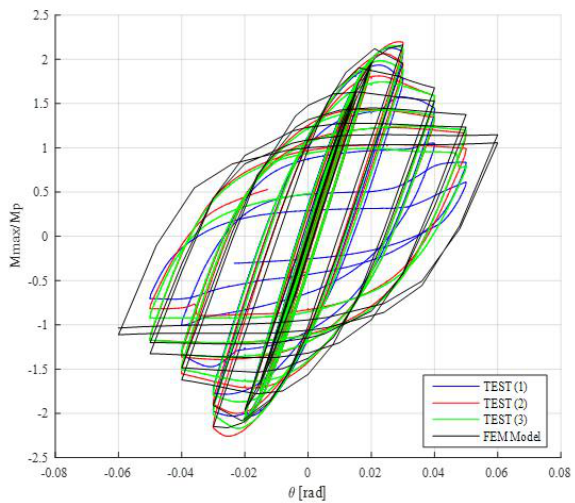
Figure 16. Comparison of normalized moment vs. rotation curve between tests and FE model.